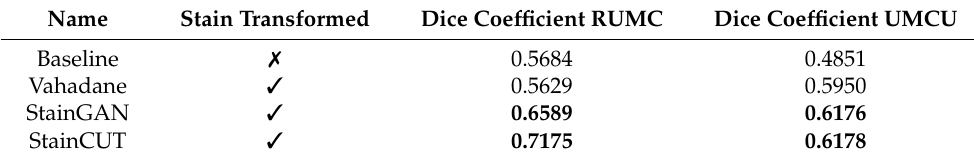
Figure 12. Distribution of the dice coefficient score for the segmentation of both datasets RUMC and UMCU, when the stain normalization is applied during training (Setting 1), and when stain normalization is applied during inference (Setting 2). The dice coefficient is calculated by comparing the generated segmentation masks and the ground truth masks for each WSI. In the boxplots, each box is drawn from the first to the third quartile. The horizontal line represents the median value and the triangle represents the mean. The whiskers indicate the minimum and maximum value of the distribution. Table 5. The mean values of the dice coefficient score for the segmentation of both datasets, when the stain normalization is applied during training (Setting 1). The dice coefficient is calculated comparing the generated masks and the ground truth masks for each WSI. The corresponding statistical tests can be found in Tables A8 and A9 in Appendix C. Bold highlights the best results that are not significantly different.